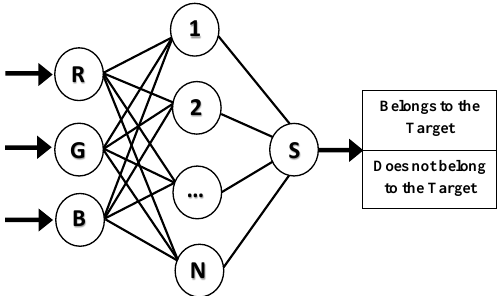
Figure 2. Neural network model for pixel discrimination.